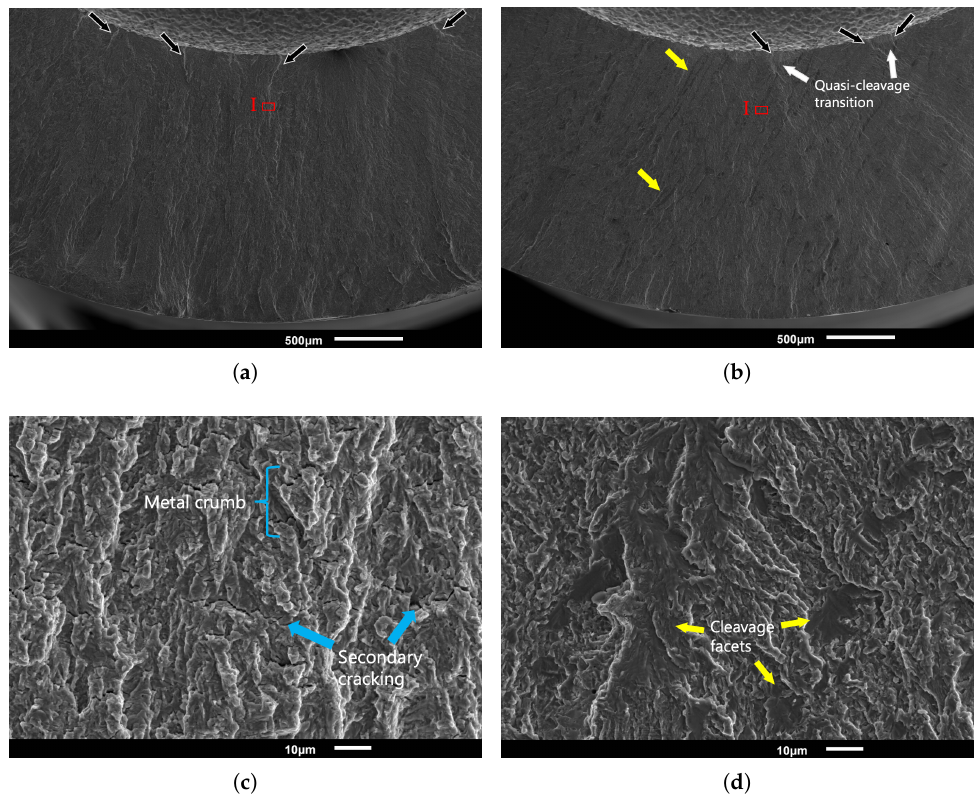
Figure 8. SEM fractographic images of notched weld metal samples. ( a ) Macroscopic overview of a 150 barg N 2 and ( b ) a 150 barg H 2 tested sample. The black arrows and yellow arrows indicate ratchet marks and quasi-cleavage facets along prior austenite grain boundaries, respectively. ( c ) Zoomed-in view of Area I in ( a ) showing metal crumbs and secondary cracking. ( d ) Zoomed-in view of Area I in ( b ) showing quasi-cleavage facets and intergranular